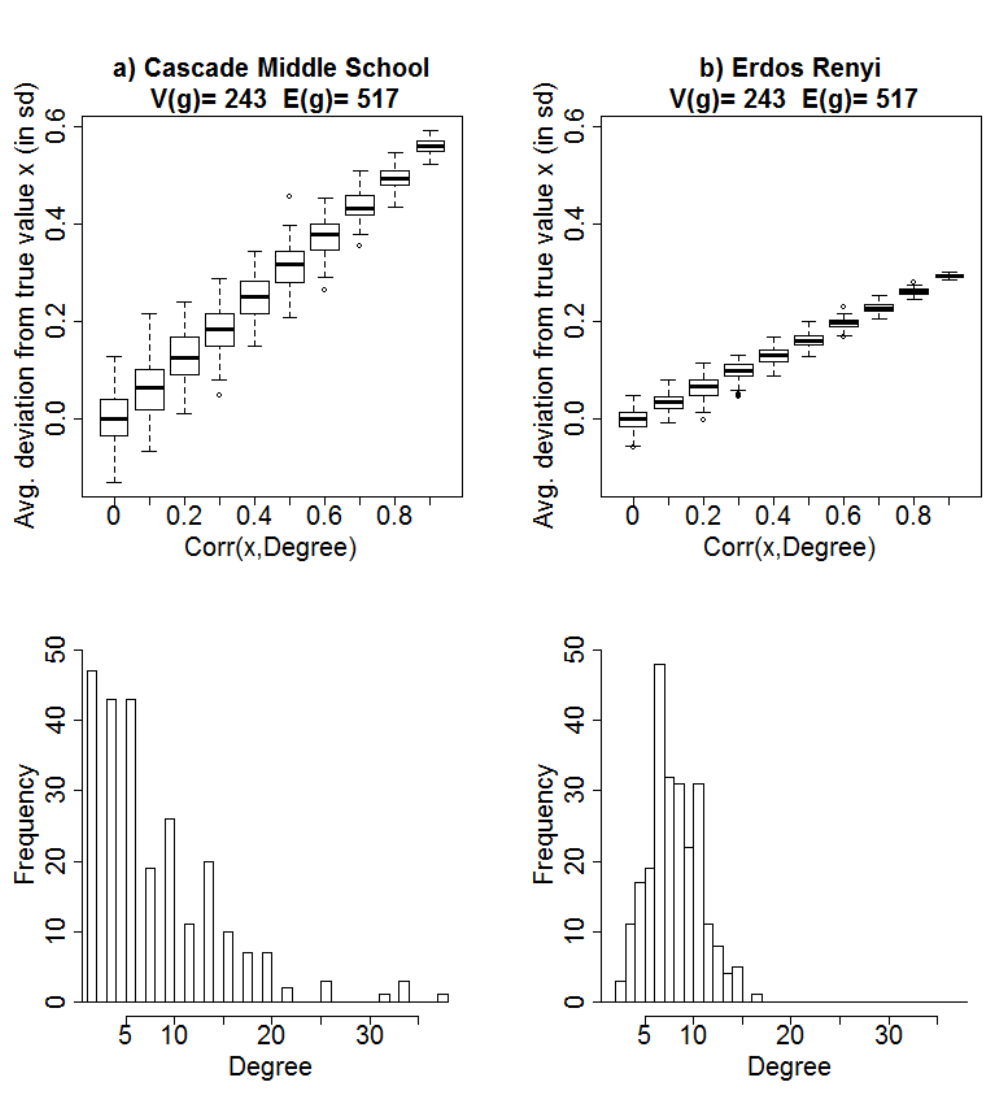
Figure 4: Experienced and true value of attribute x (correlated with Degree)